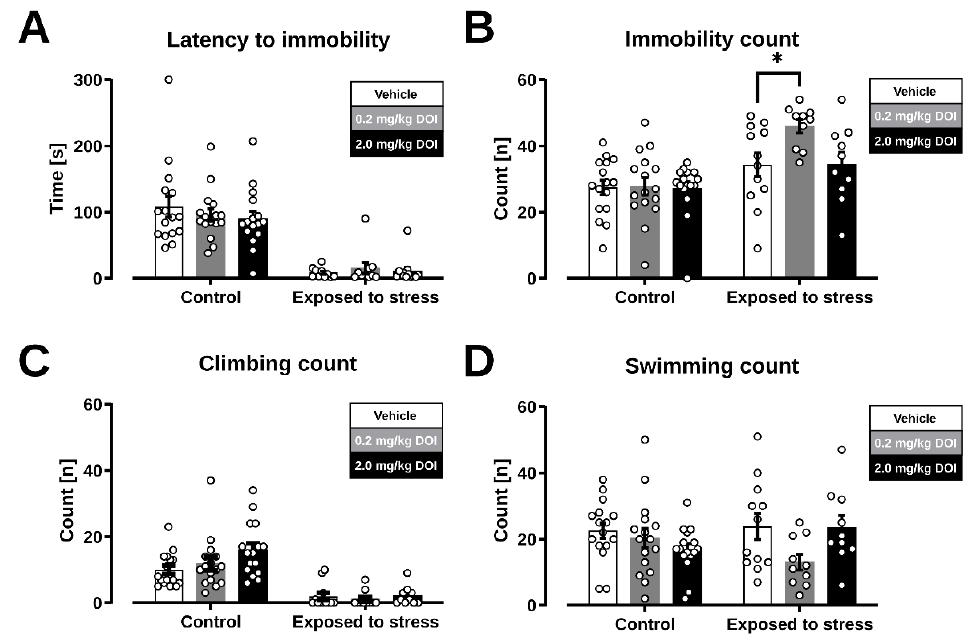
Figure 2. Effect of DOI on passive stress-coping behavior in the forced swim test in mice. ( A ) Latency to immobility. ( B ) Immobility count. ( C ) Climbing behavior. ( D ) Swimming behavior. Plots represent classification of 5 s intervals. Data are represented as mean values +/ − SEM. * p < 0.05 vs. Veh group.